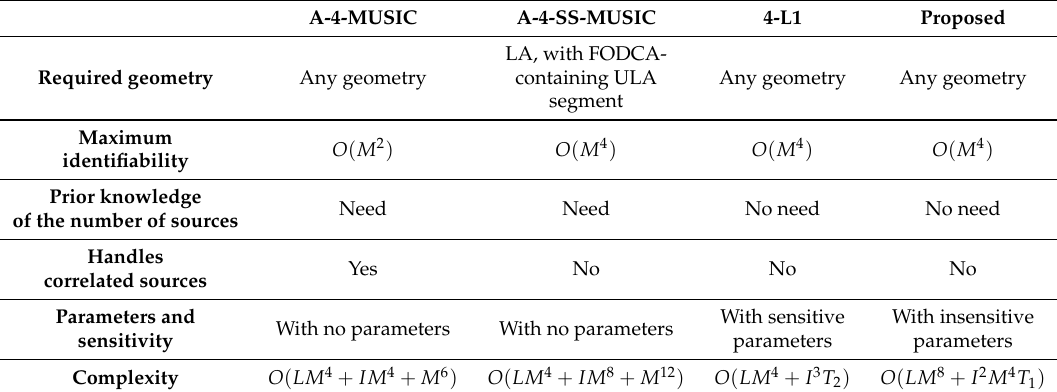
Table 1. Comparison with state-of-the-art methods. 4-L1: fourth-order cumulants (FOCs) vector-based L1-norm method; A-4-MUSIC: non-redundant version of 4-MUSIC with averaging strategy; A-4-SS-MUSIC: FOCs vector-based spatial smoothing (SS)-MUSIC with averaging strategy; FODCA: fourth-order difference co-array; ULA: uniform linear